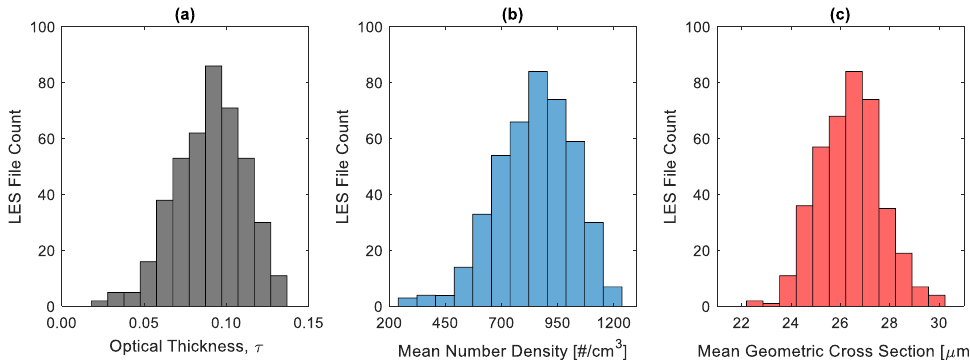
Figure 2. ( a ) Histogram of optical thickness from 432 LES output files. Values in the distribution range from 0.02 to 0.14, with an average optical thickness of 0.09, a standard deviation of 0.02, and a relative dispersion of 0.222. ( b ) Histogram of subvolume mean number density from 432 LES output files. Values in the distribution range from 243 to 1227 droplets per cubic centimeter, with an average of 846 cm −3 , a standard deviation of 174 cm −3 , and a relative dispersion of 0.206. ( c ) Histogram of subvolume mean geometric cross section from 432 LES output files. Values range from 22 to 30 μm 2 , with a mean of 26.4 μm 2 , a standard deviation of 1.27 μm 2 , and a relative dispersion of 0.048. Mean number density and total optical thickness are highly correlated (R 2 = 0.97), as shown in panel (a) of Figure 3, while mean geometric cross section and total optical thickness are only weakly correlated (R 2 = 0.49), as can be seen in the wider spread of points in panel (b) of Figure 3. The strong correlation of optical thickness and mean number density is reminiscent of the expected behavior of a cloud undergoing inhomogeneous mixing: in that case, variations in liquid water content are driven by variations in droplet number density, with droplet diameter remaining constant. Indeed, this type of behavior in the Pi Chamber has been noted in previous work [39]. Similar behavior can be observed in precipitation: the variance of the drop size distribution (or its moments like rainfall rate) can be primarily driven by either the number of drops or by the underlying variability in the size distribution shape, and the dependence even varies with scale [40].